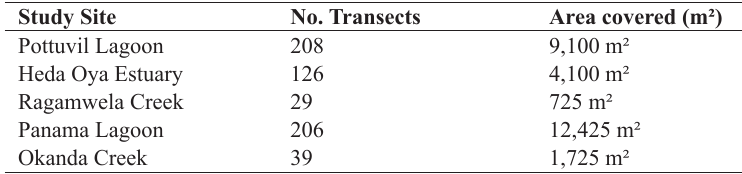
Table 1: Study locations with number of transects studied in each